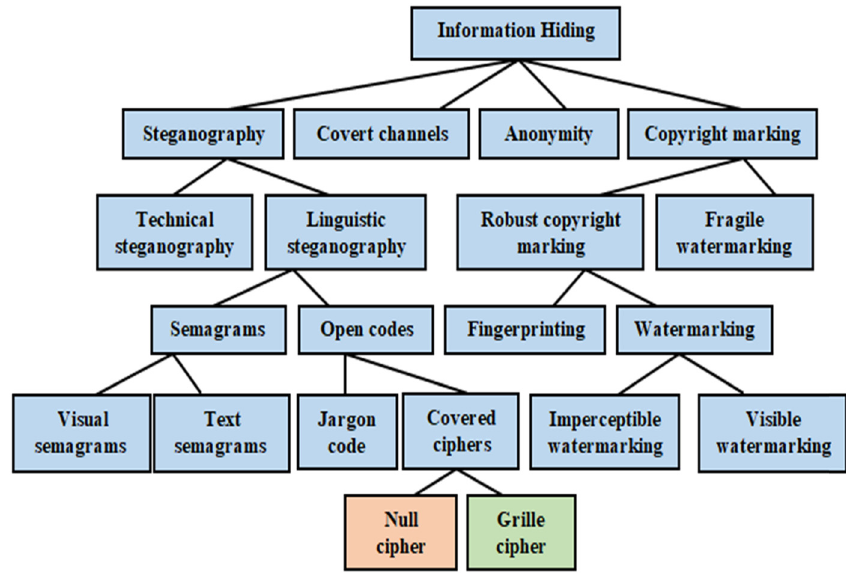
Figure 1: Information hiding classi fi cation adapted from Bauer [ 6 ]